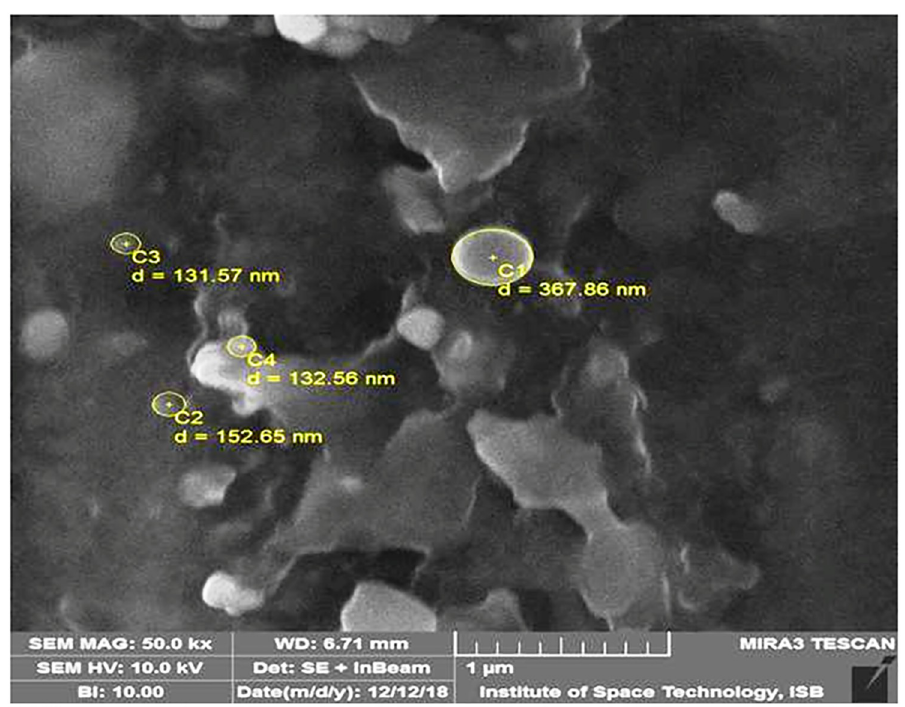
Fig 1. Morphological evaluation of chitosan nanoparticles loaded with oregano oil by scanning electron microscopy at 50000 x and 10.0 kV. The nanoparticles are in the range of 40–500 nm and show some agglomeration.